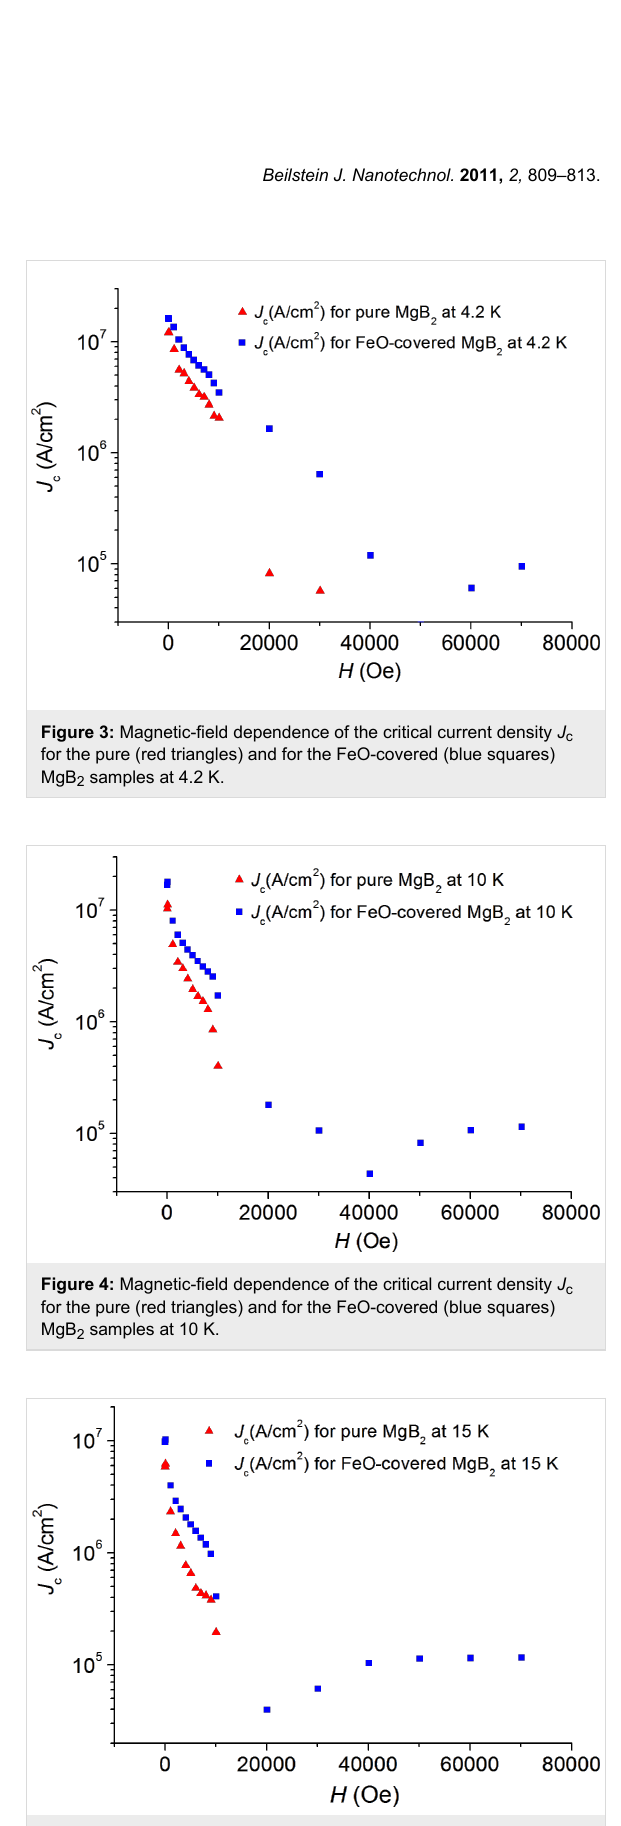
Figure 5: Magnetic-field dependence of the critical current density J c for the pure (red triangles) and for the FeO-covered (blue squares) MgB 2 samples at 15